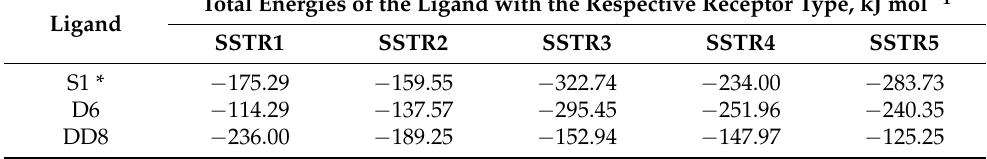
Table 7. Calculated total energy of ligand–peptide complexes. Total Energies of the Ligand with the Respective Receptor Type, kJ mol − 1 Ligand